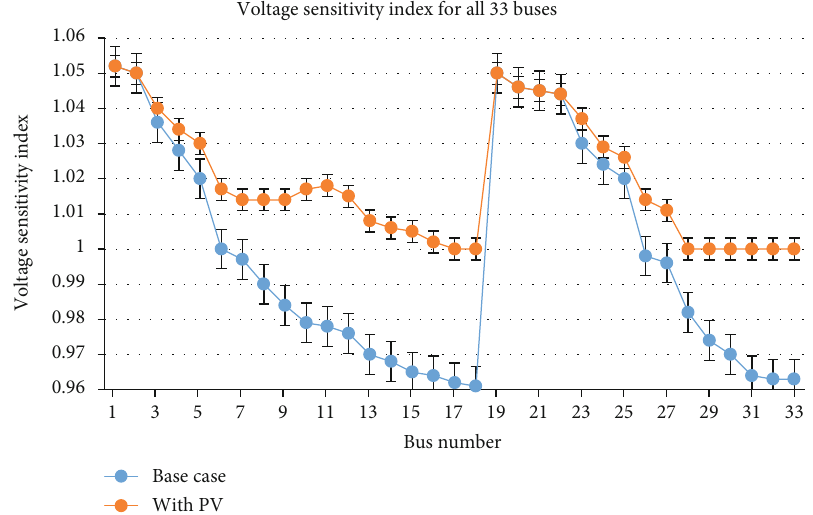
Figure 4: VSI value before and after PV